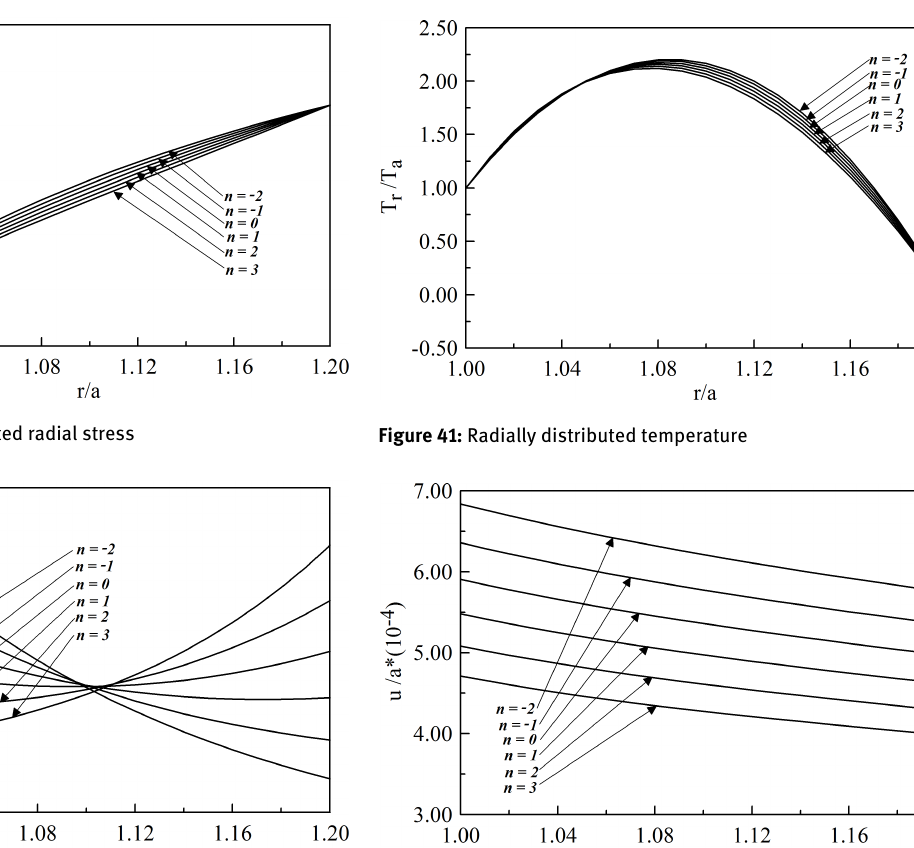
Figure 40: Radially distributed von-Mises stress